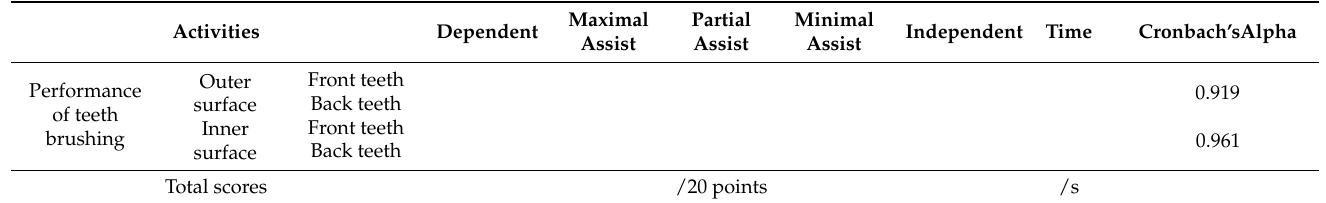
Table 1. Tooth-brushing performance and time